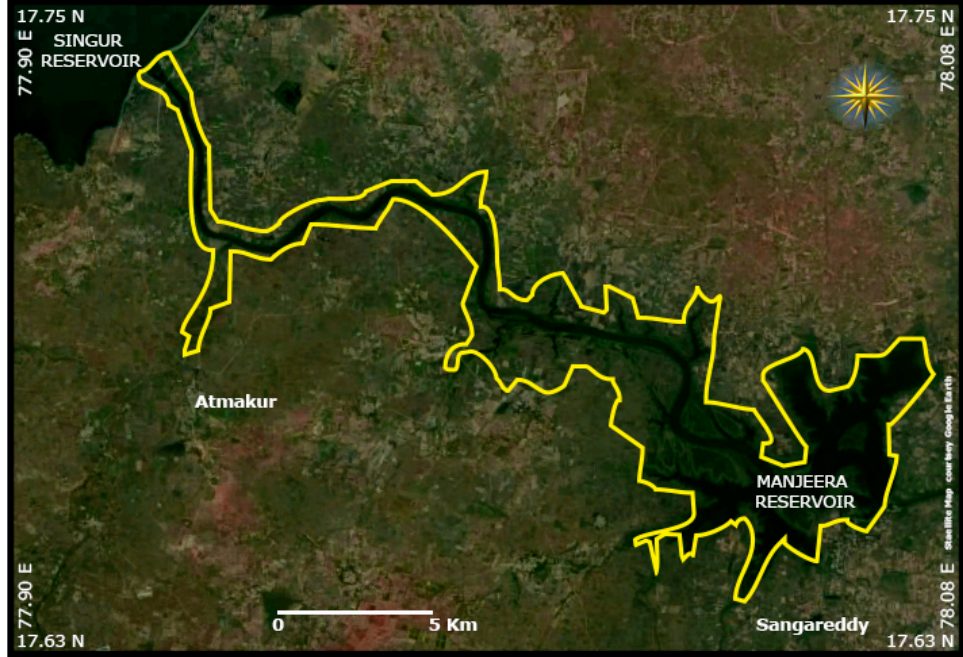
Figure 1. Map of the Manjeera Wildlife Sanctuary, Medak District, Andhra Pradesh,